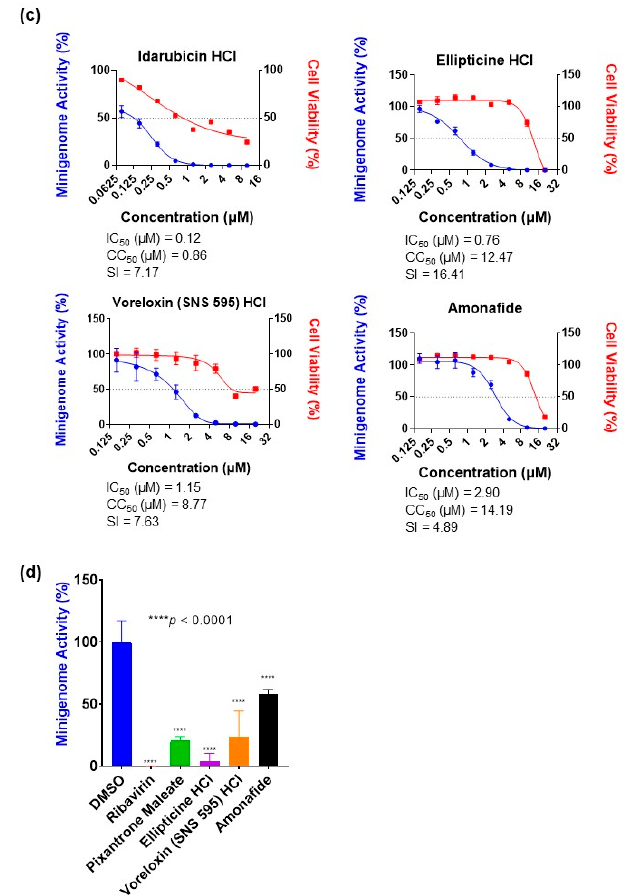
Figure 4. Inhibitory effects of identified candidates and topoisomerase II inhibitors against JUNV MG. ( a ) Inhibitory effects of the positive controls MPA and ribavirin against JUNV MG. Huh-7 cells were transfected with the JUNV MG, JUNV NP, and JUNV L plasmids. Compounds were added at the indicated concentrations in triplicate after 12 h. MG activity and cell viability were assessed at 36 h post-treatment. ( b ) Inhibitory effects of pixantrone maleate, proflavine, quinacrine dihydrochloride, and quinacrine dihydrochloride dihydrate against JUNV MG. Compound treatment and assessment were performed as described in ( a ). ( c ) Inhibitory effects of the topoisomerase II inhibitors idarubicin hydrochloride, ellipticine hydrochloride, voreloxin (SNS 595) hydrochloride, and amonafide against JUNV MG. Compound treatment and assessment were performed as described in ( a ). ( d ) Inhibitory effects of the topoisomerase II inhibitors pixantrone maleate, ellipticine hydrochloride, voreloxin (SNS 595) hydrochloride, and amonafide against LCMV MG. BHK-21 cells were transfected with the LCMV MG, LCMV NP, and LCMV L plasmids. Compounds were added at 5 µM in octuplicate after 12 h; Ribavirin (100 µ M) was used as a positive control. MG activity was assessed at 36 h post-treatment. Data are presented as means ± SD and are representative of three independent experiments. All results were normalized to DMSO-treated wells.